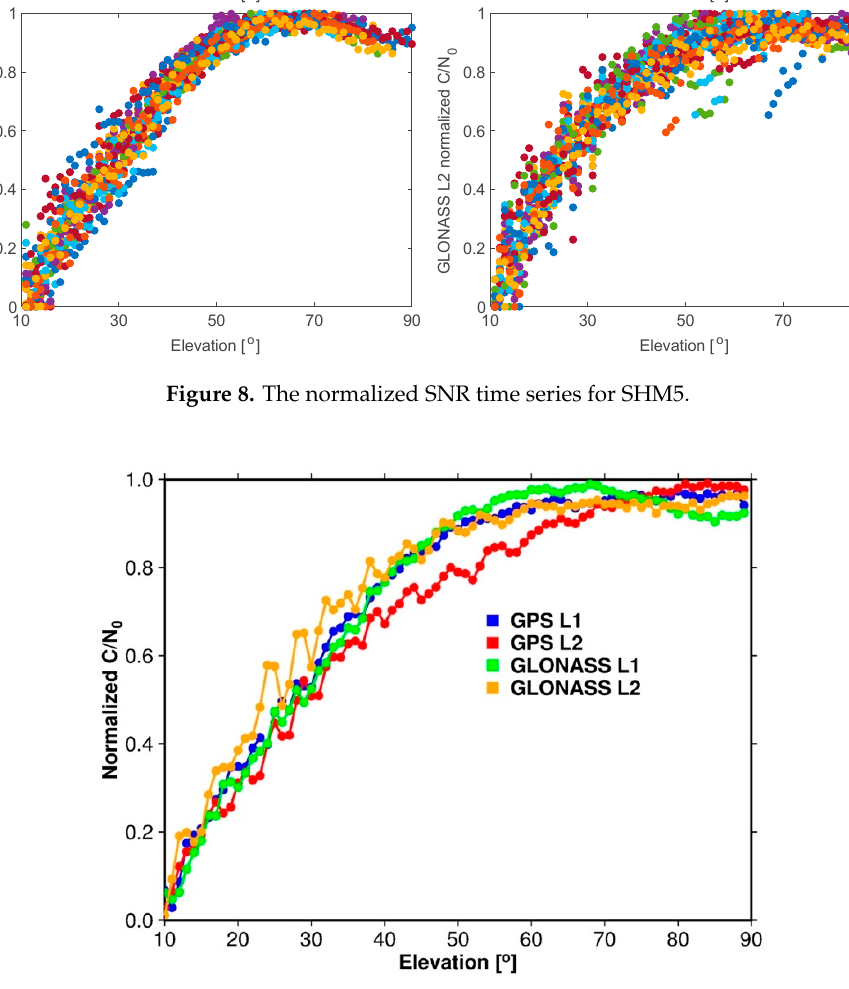
Figure 9. The mean value of normalized SNR of all satellites for one elevation in dual-frequency GPS and GLONASS.